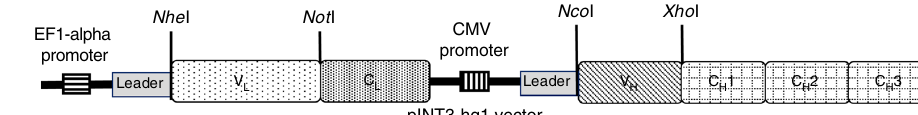
Fig. 6 Schematic representation of the genetic elements present in the